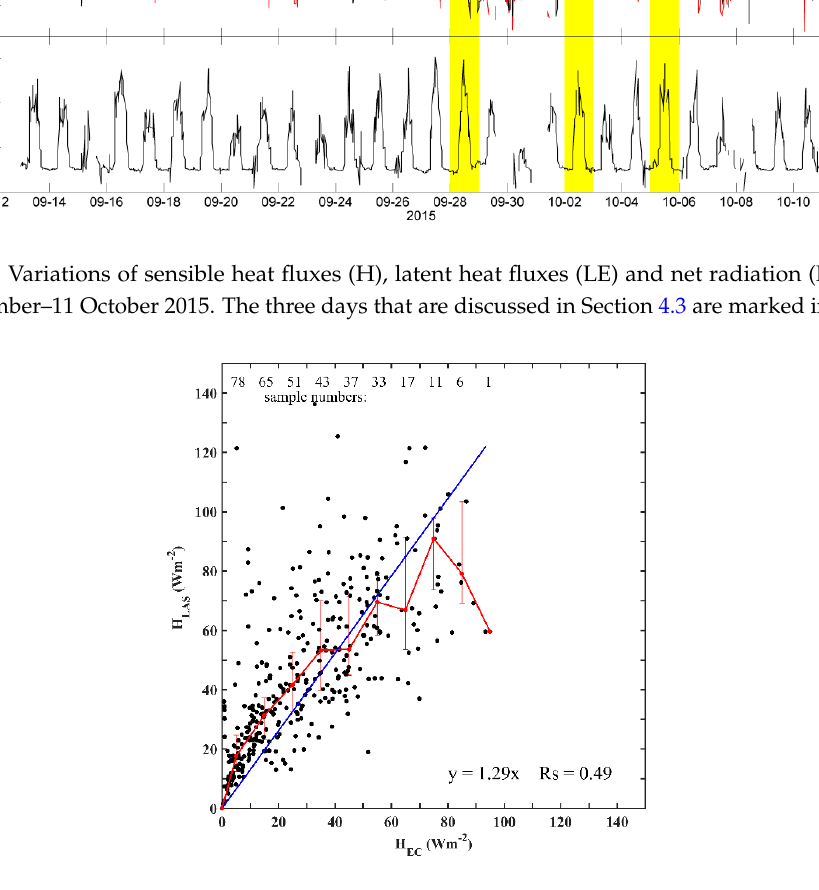
Figure 7. Variations of H LAS and H EC when the sensible heat fluxes were greater than zero from 12 September–11 October 2015. The red points represent the median values binned at 5 W m − 2 of the interval. The corresponding bars represent the interquartile ranges. The sample numbers are also shown in the figure. The regression lines are plotted in blue. The slopes and determination coefficients are also shown in the picture.